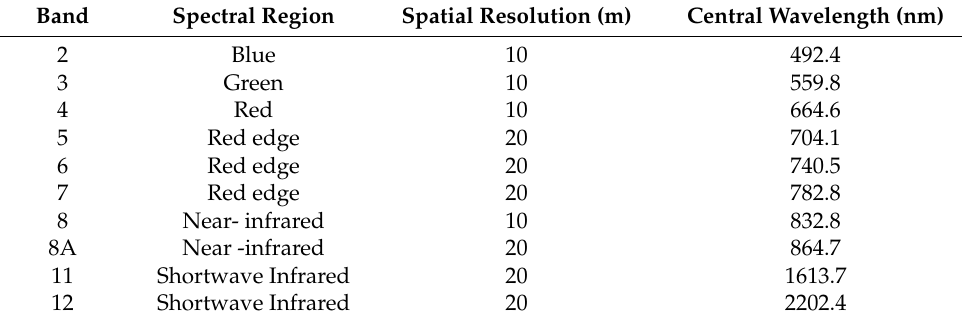
Table 2. Sentinel-2 spectral